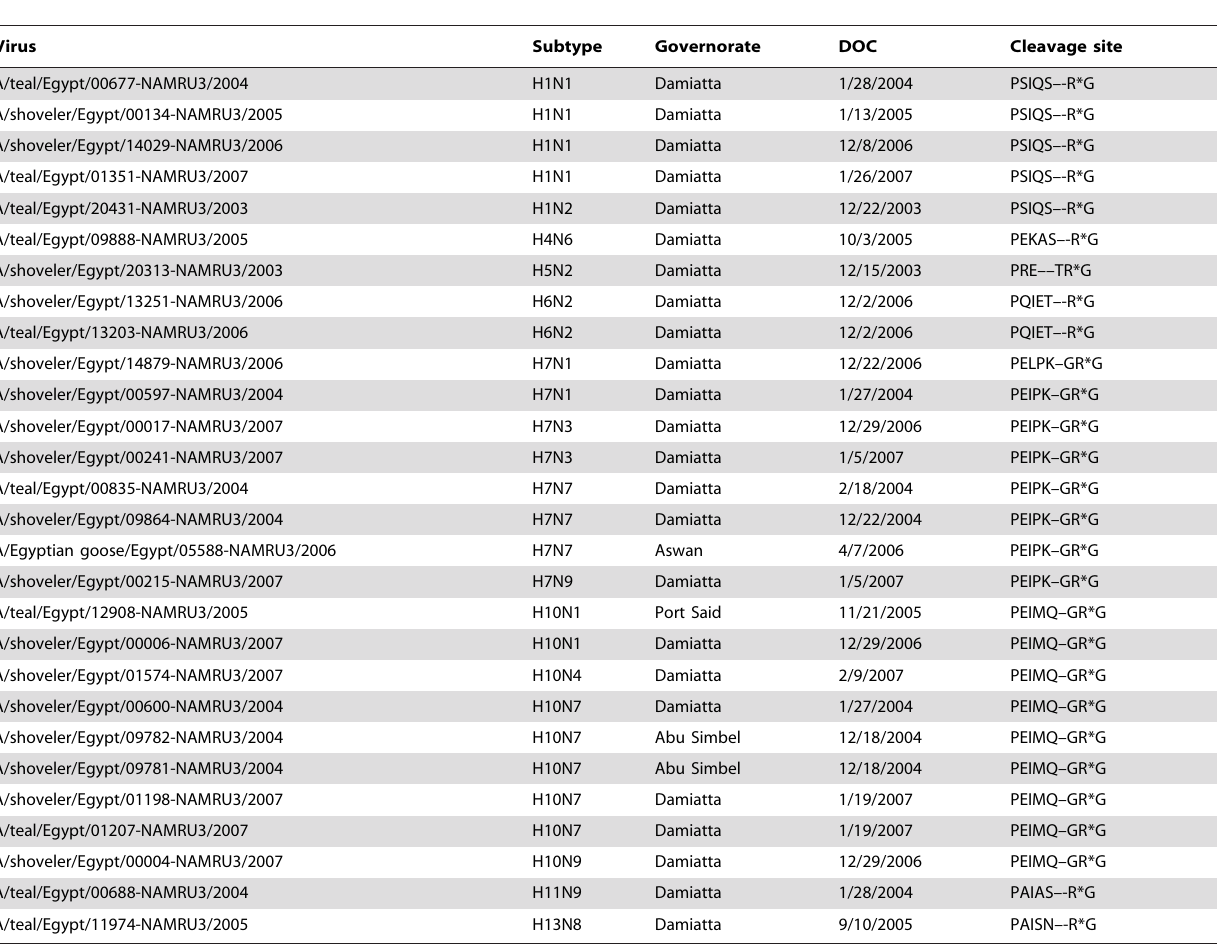
Table 2. Avian influenza viruses analyzed in this study with subtype, collection site (Governorate in Egypt), date of collection (DOC) and amino acid sequence of the cleavage site (*) of the HA0